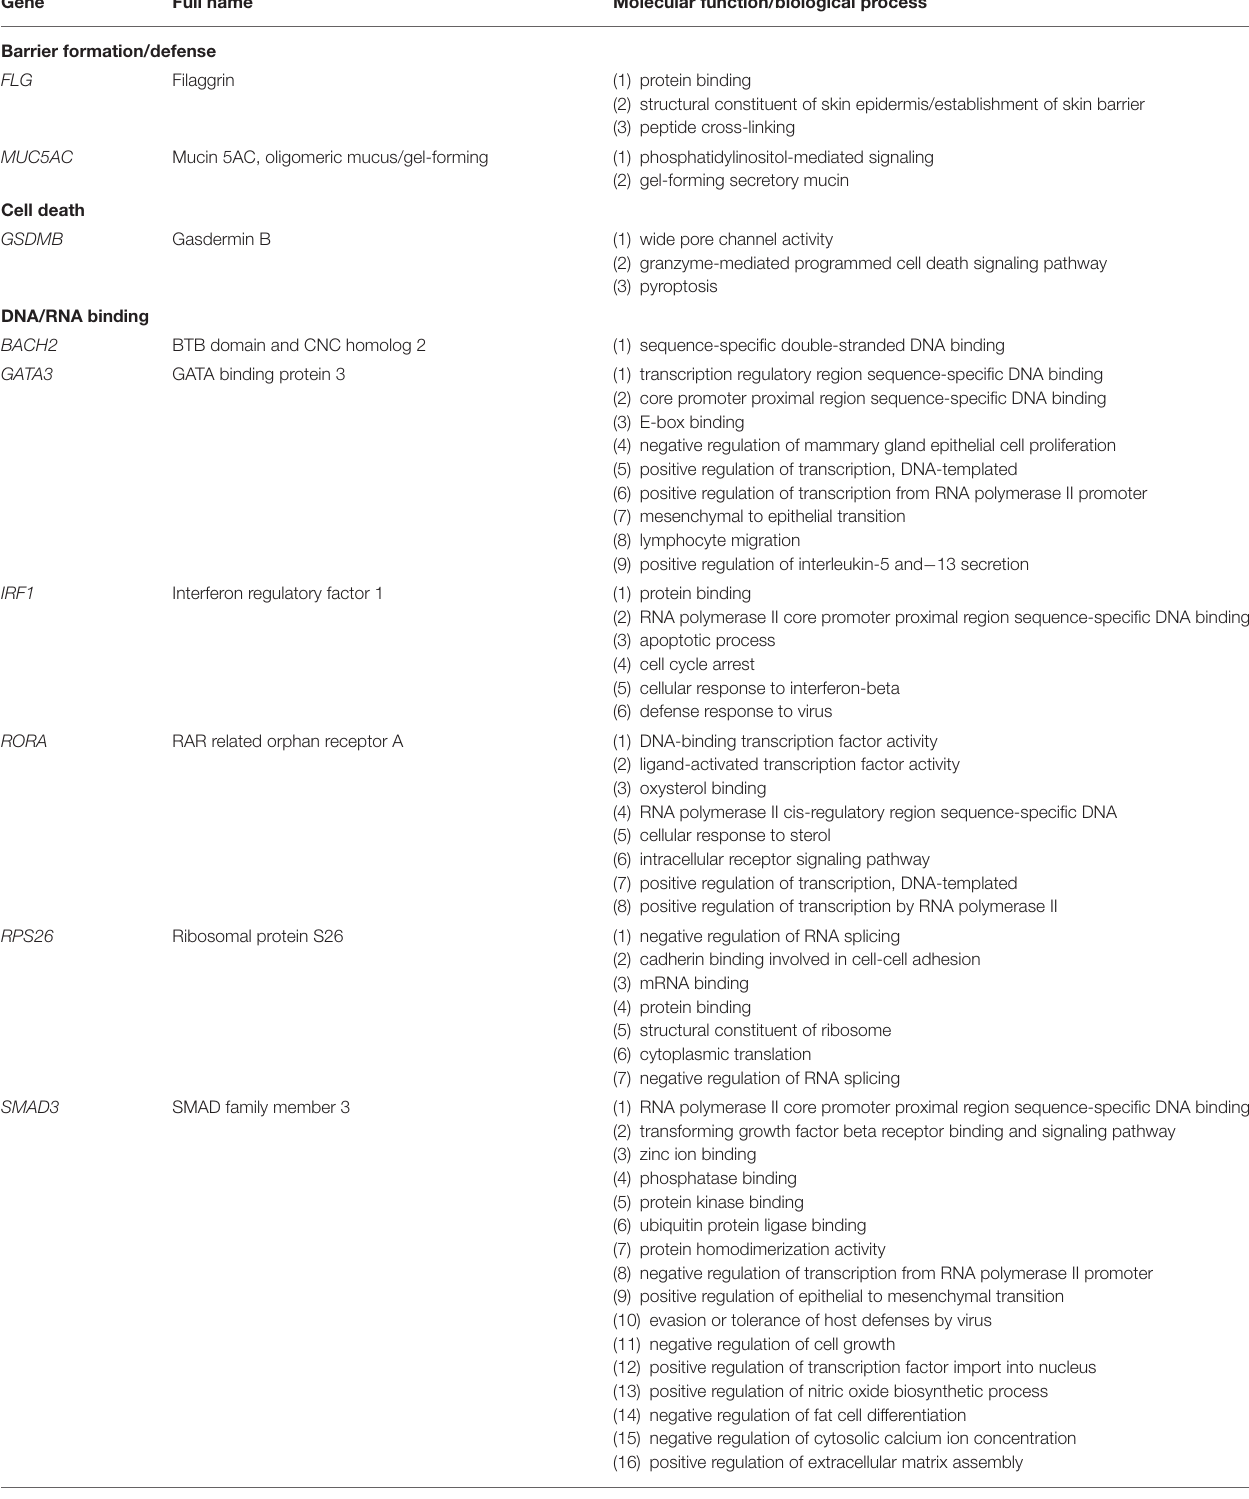
TABLE 5 | Gene function of candidate causal